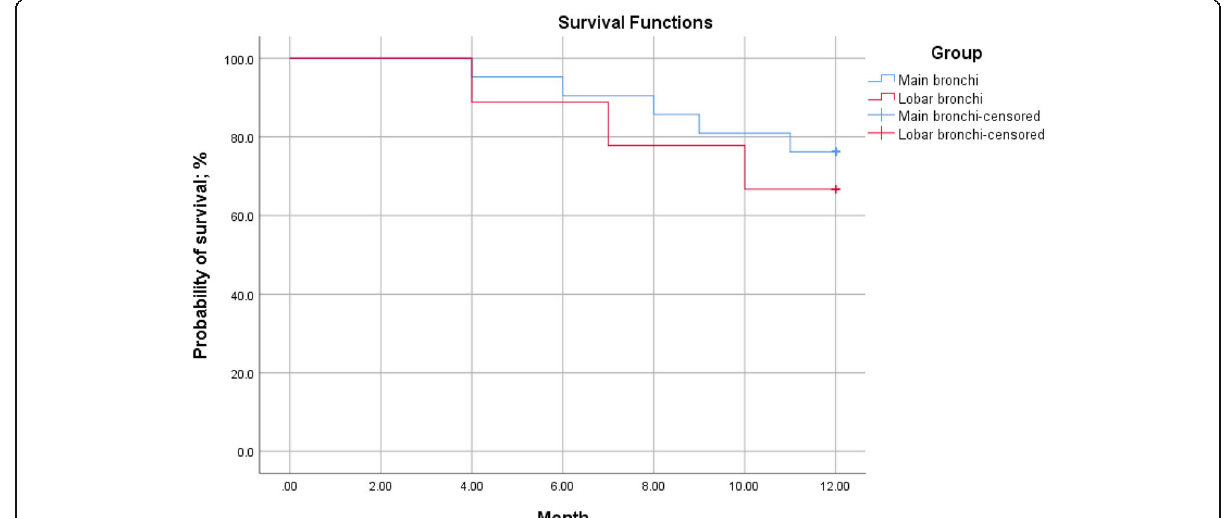
Fig. 2 Comparison of the median survival by the Kaplan-Meier method; for main bronchi patients and lobar bronchi patients in group A patients. The median survival; 10.77±0.44 months (95% CI= 9.90 – 11.63), T test = 0.629, P =